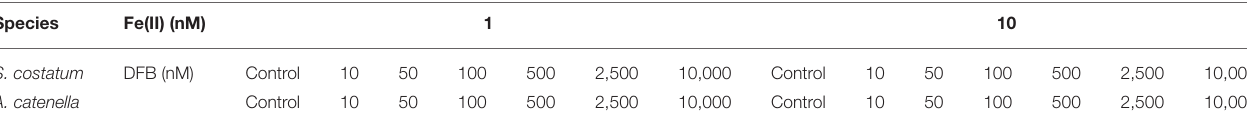
TABLE 1 | Experimental setup, including the diatom ( S. costatum ) and dinoflagellate ( A. catenella ) species, the two iron(II) conditions and the five desferrioxamine B (DFB) treatments with the respective final concentrations (nM) reached in the experiment performed.